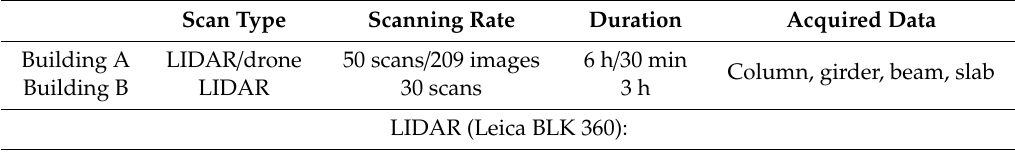
Table 1. Target buildings used to acquire point cloud